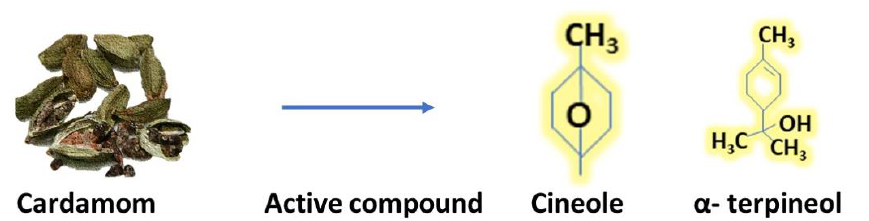
Figure 3. Active compound of cardamom (Cineole and α -terpineol).